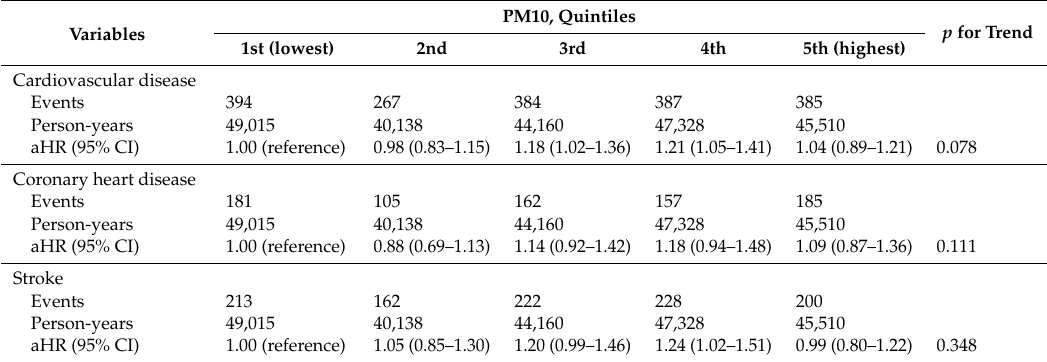
Table 3. Adjusted hazard ratios (95% CI) for cardiovascular disease according to post-diagnosis PM10 levels among 5-year cancer survivors.